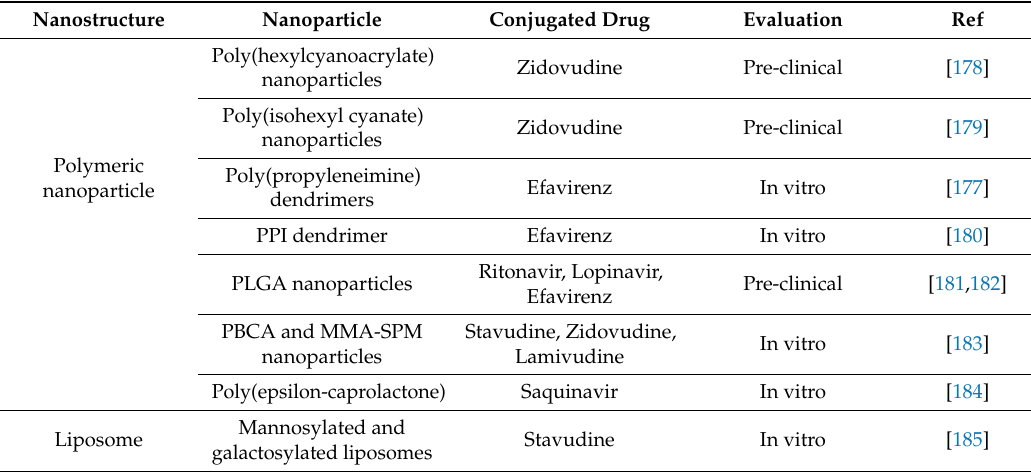
Table 4. Therapeutic nanoparticle drug formulations for the treatment of AIDS